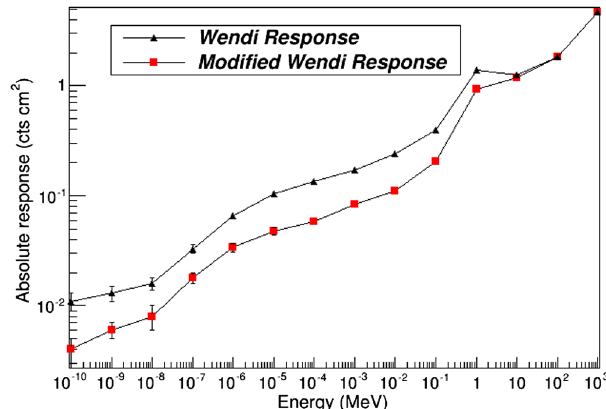
FIG. 3. G eant4 WENDI-2 response function. The black triangle points represent the response function of the dosimeter itself, and the red square points represent the response function of the dosimeter behind the wooden panel.